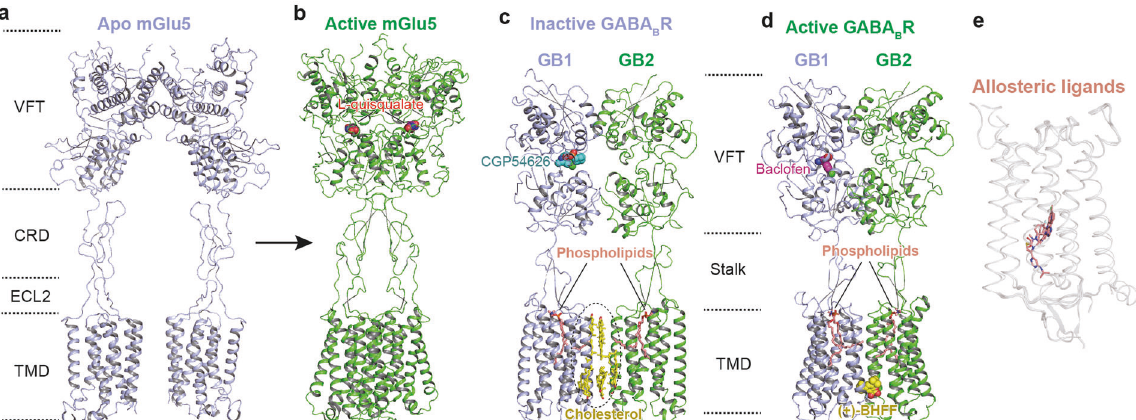
Fig. 7 Structural features and activation mechanism of class C GPCRs. The structures of mGlu5 in resting state ( a , PDB code: 6N52) and active state ( b , PDB code: 6N51), as well as GABA B R in inactive ( c , PDB code: 7C7S) and active states ( d , PDB code: 7C7Q) are displayed, respectively. Agonists L-quisqualate ( b , magenta) and antagonist CGP54626 ( c , cyan) of mGlu5 as well as agonist baclofen ( d , magenta) and allosteric modulator ( + )-BHFF ( d , yellow) of GABA B R are shown as spheres. Cholesterols ( c , yellow) and phospholipids ( c , d , salmon) are indicated as sticks. Binding of allosteric ligands to TMD of class C GPCR is indicated as salmon sticks ( e , PDB codes: 4OR2, 4OO9, 5CGC, and 6FFH)